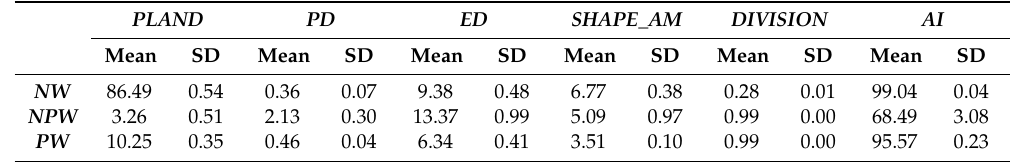
Table 6. Average and standard deviation of class-level metrics during